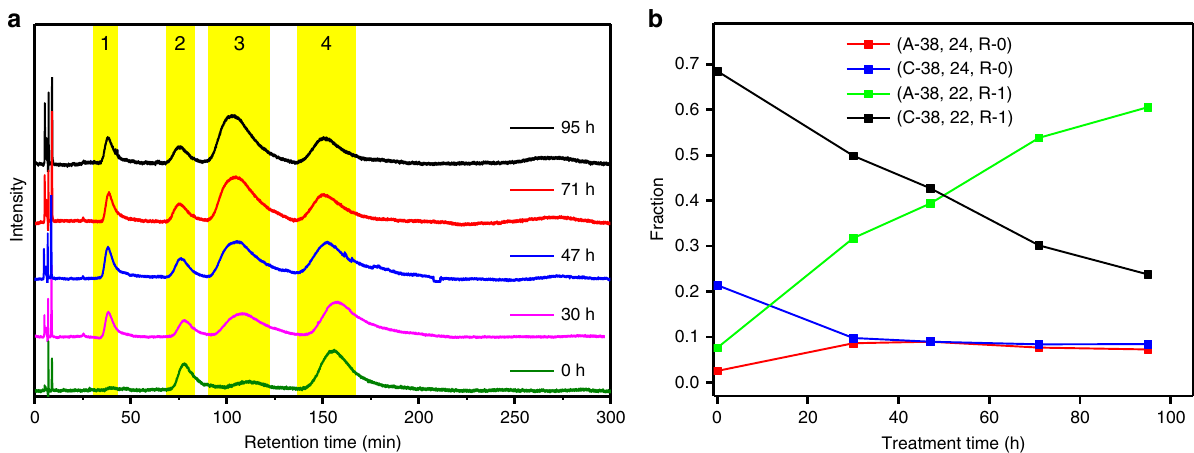
Fig. 6 Experiment showing the conversion of clockwise to anticlockwise clusters. HPL chromatograms ( a ) and evolution of different clusters species as a function of time ( b ). The sample was prepared by ligand exchange reaction of (C-38, 24, R-0) and R-BINAS. Some enantiopure cluster (C-38, 24, R-0), was added to adjust the average number of incorporated R-BINAS in the sample, which was x R (cid:1) BINAS ¼ 0 : 76. The sample was then heated to 70 °C and chromatograms were measured as a function of time. The peaks are assigned as follows: Peak 1 , (A-38, 24, R-0); Peak 2 , (C-38, 24, R-0); Peak 3 , (A-38, 22, R-1); Peak 4 , (C-38, 22,